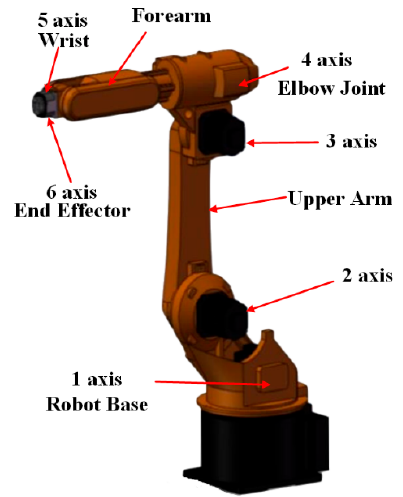
Figure 1. Overall contour map of the RB20 industrial robot.